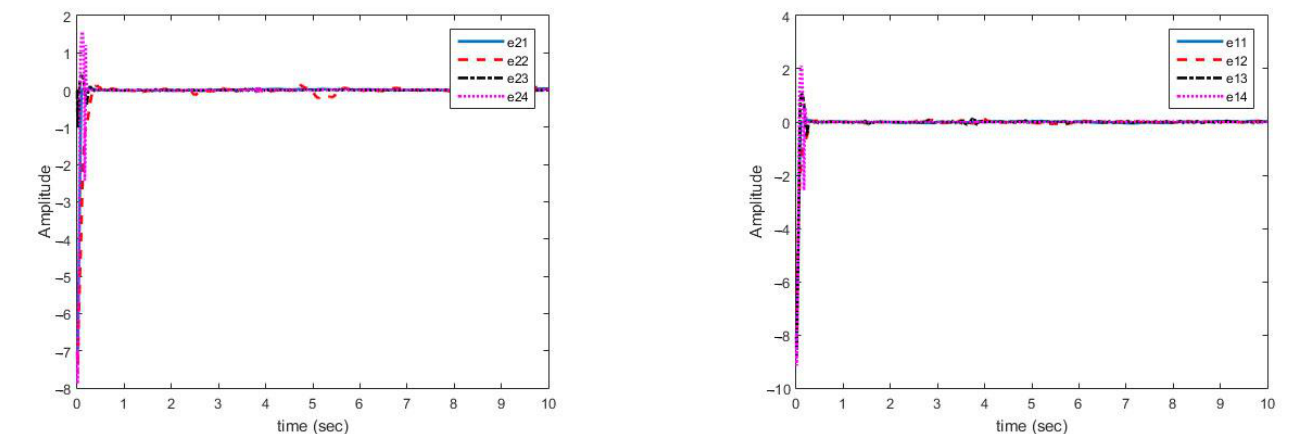
Figure 6. Synchronization error curves for disturbance and structural uncertainty (case B).